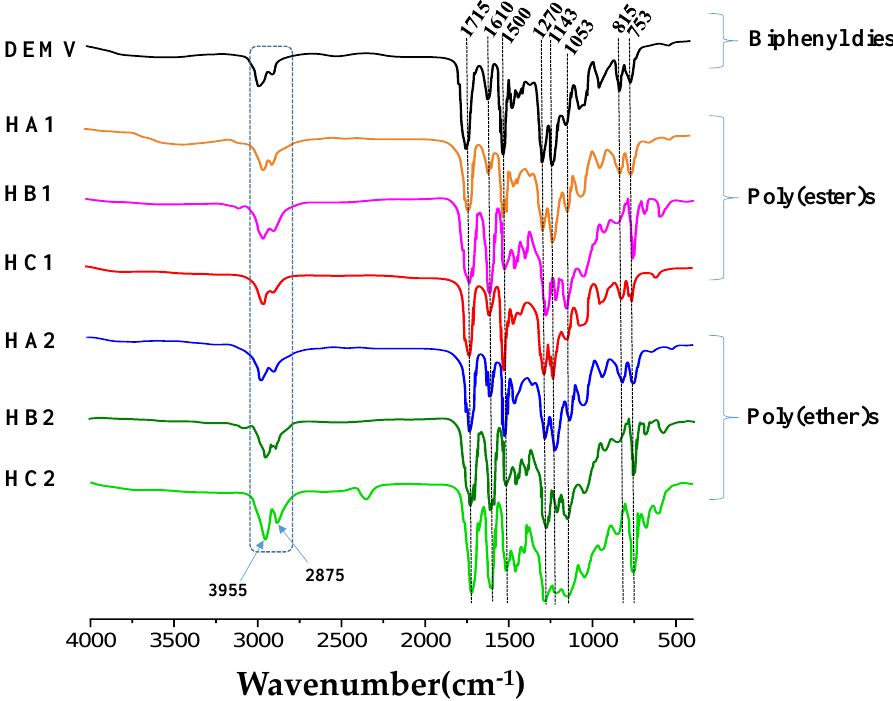
Figure 5. FTIR spectra of poly(ether-ester)s .